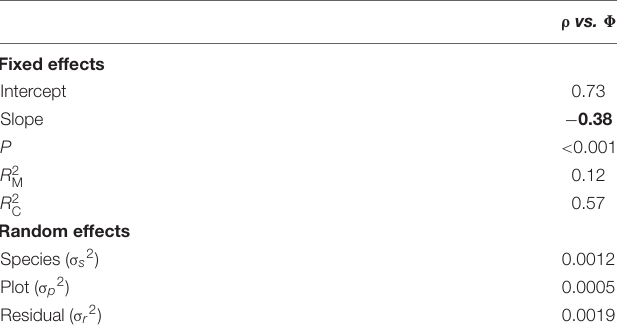
TABLE 2 | Mixed effect modeling of relationships between wood density ( ρ ) and water content per unit tissue volume ( (cid:56) ).